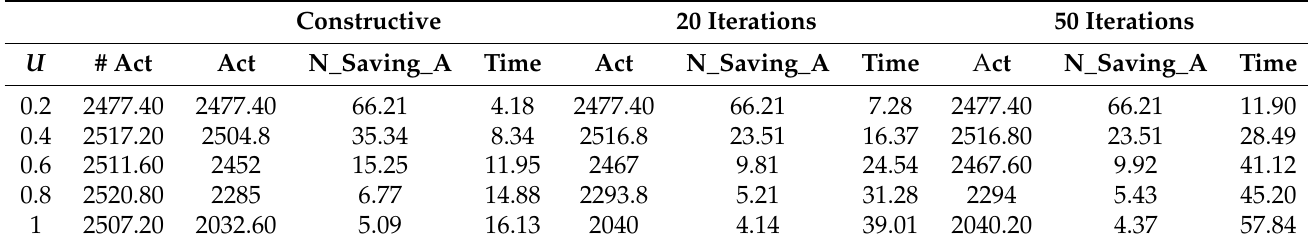
Table 9. 12eight servers-1000 flows-Activation scheduling—Phase 2 Multistart